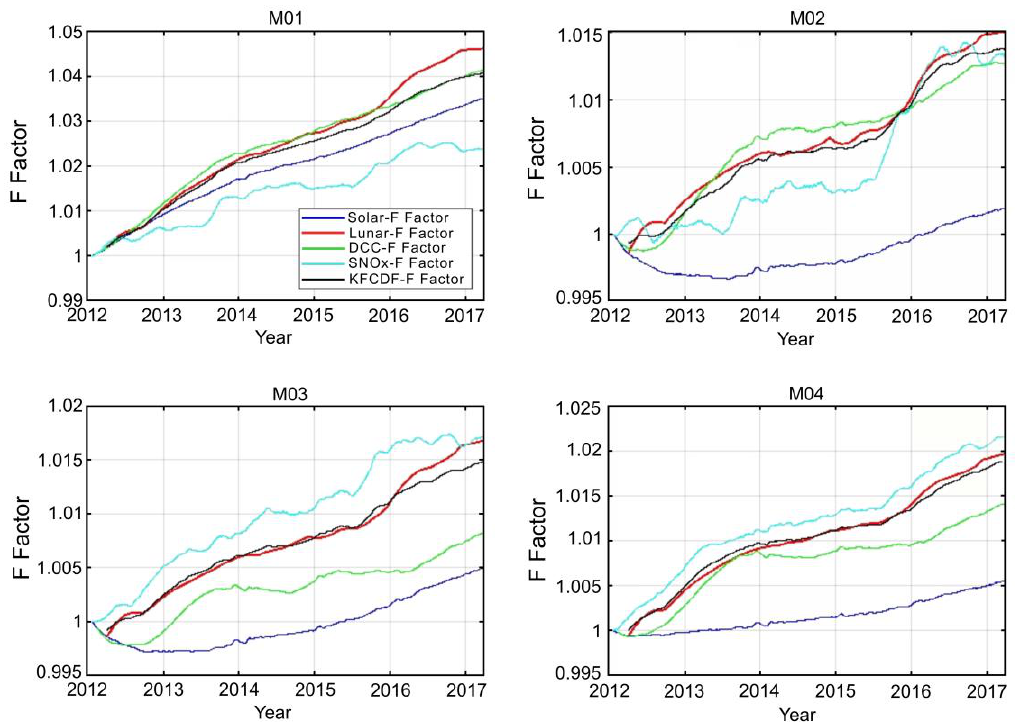
Figure 4. Examples of Kalman-filtering-based assimilation of time series of solar-F, lunar-F, DCC-F and simultaneous nadir overpass (SNO)x-F factors for M1-M4 of SNPP VIIRS. In each panel, the black curve shows the optimal F factor time series estimated with the Kalman-filter-based calibration data fusion (KFCDF) model for the corresponding band.